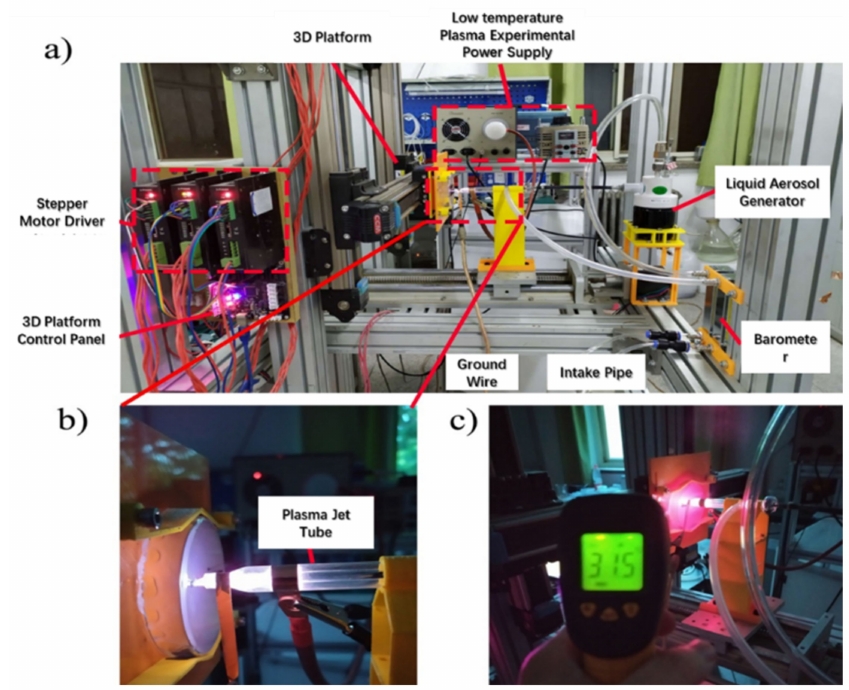
Figure 2. The plasma spraying device. ( a ) introduction of the plasma spraying device ( b ) the process of the low-temperature-plasma spraying; ( c ) the temperature of the